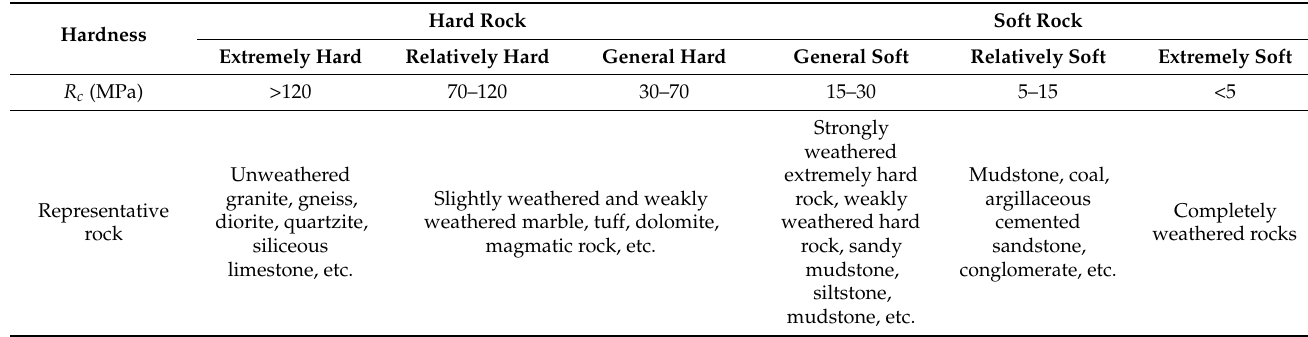
Table 4. Classification of the hardness of the middle rock pillar.